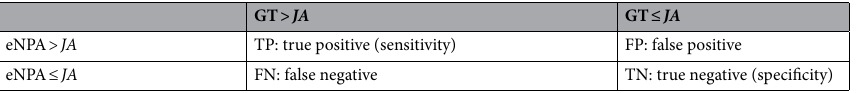
Table 1. Contingency table for validation. GT ground truth, JA judgement area, NPA non-perfusion